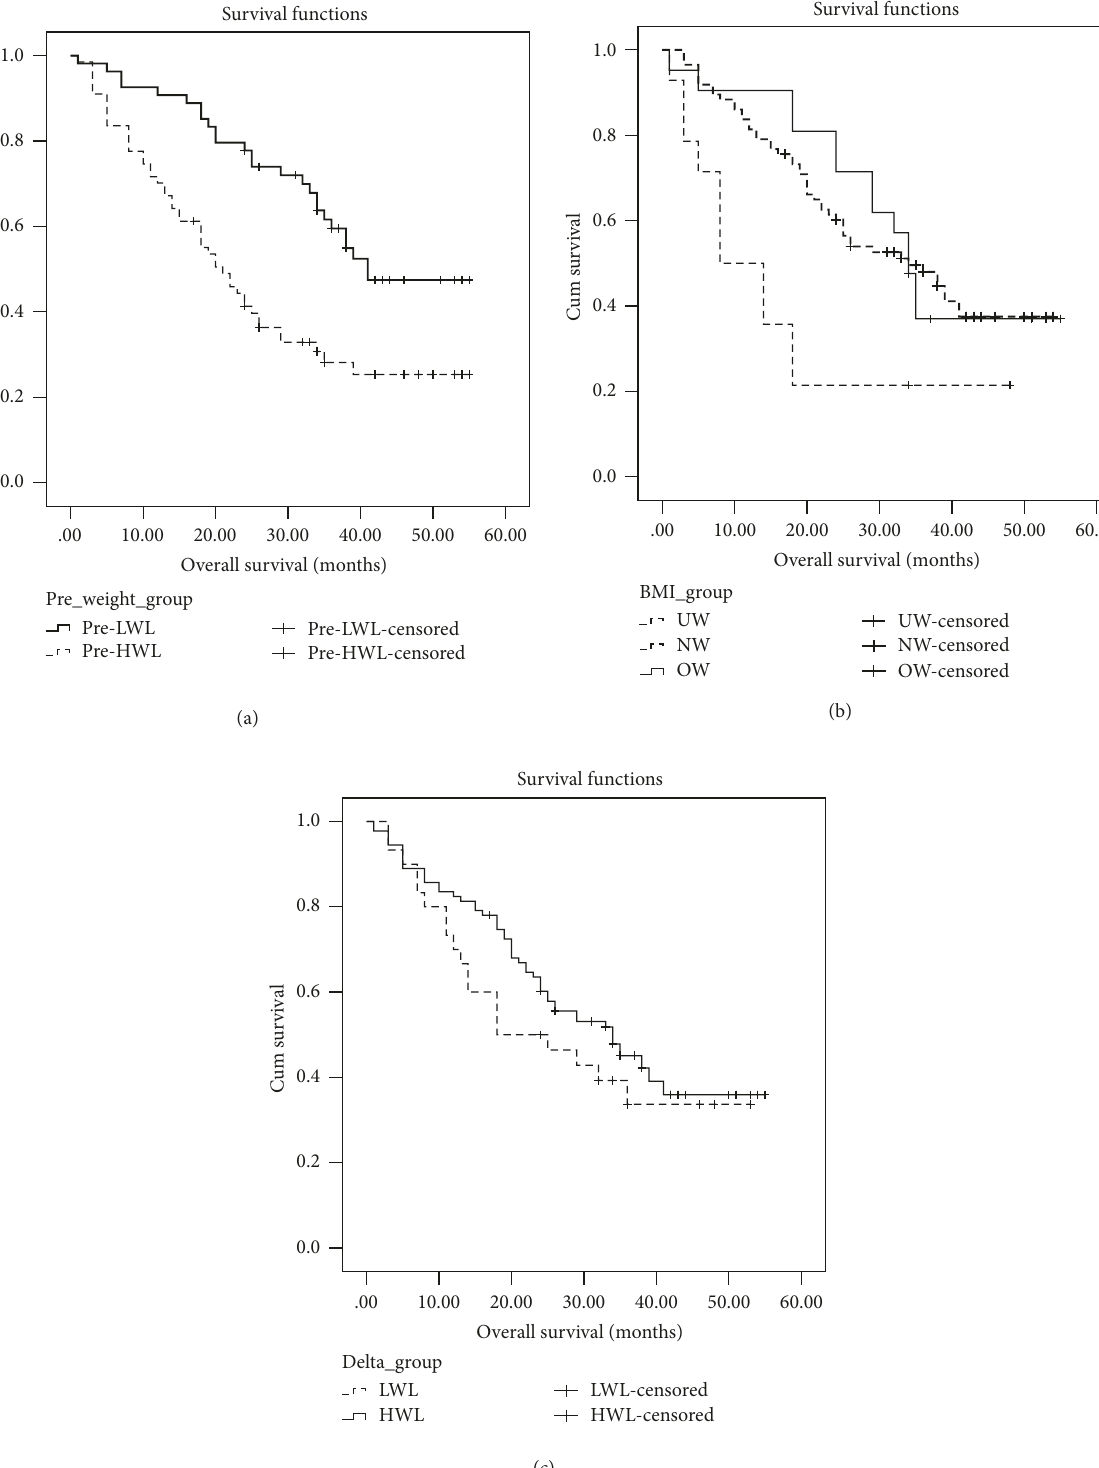
Figure 1: Kaplan-Meier survival curve analysis for the 3-year overall survival for the 121 patients with esophageal carcinoma undergoing surgery and adjuvant chemotherapy stratified by the (a) pretreatment weight loss (log-rank test, 𝑃 < 0.001 ), (b) body mass index ( 𝑃 = 0.297 ), and (c) weight loss during the treatment ( 𝑃 = 0.007